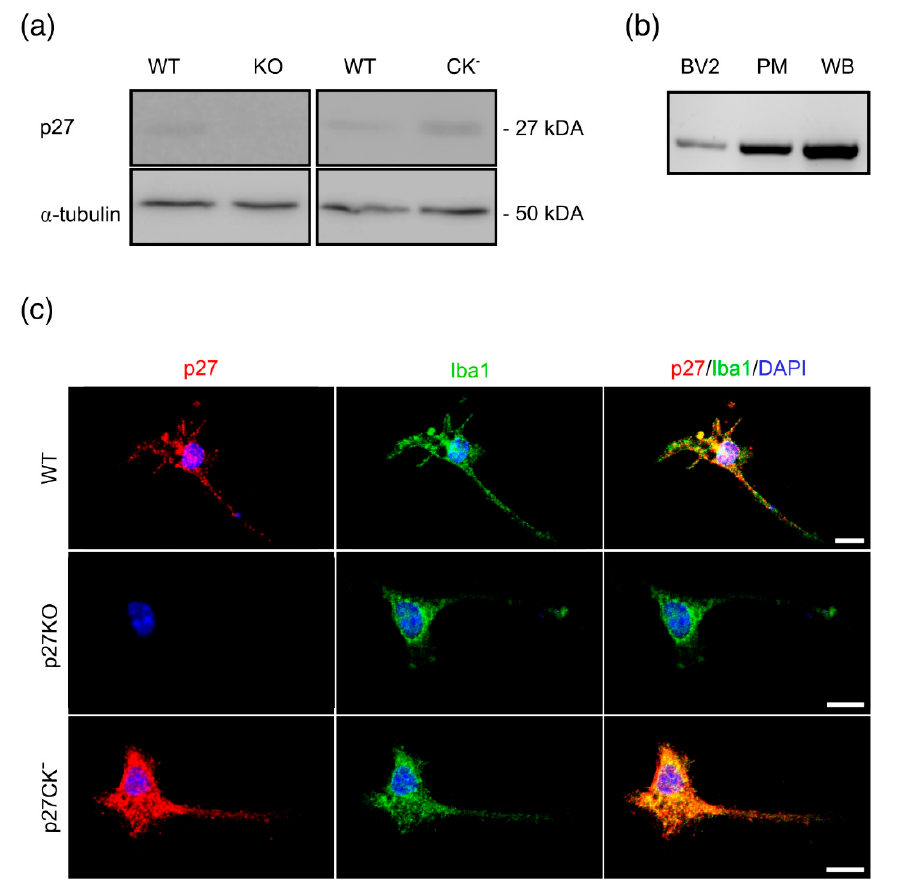
Figure 1. p27 is expressed in microglial cells. ( a ) Representative Western blots showing the expression of p27 in primary wild type (WT) and p27CK − microglial cells. α -tubulin was used as a loading control. ( b ) RT-PCR of p27 expression in a murine microglial cell line (BV2 cells), in primary microglial cells (PM), and in a whole brain (WB) extract. ( c ) Immunofluorescent staining of primary p27WT, p27KO, and p27CK − microglia. Cells were stained with an anti-p27 (red) and an anti-Iba1 (green) antibody and their nuclei were counterstained with DAPI (blue). Scale bar = 10 µ m. See also Figure S1.